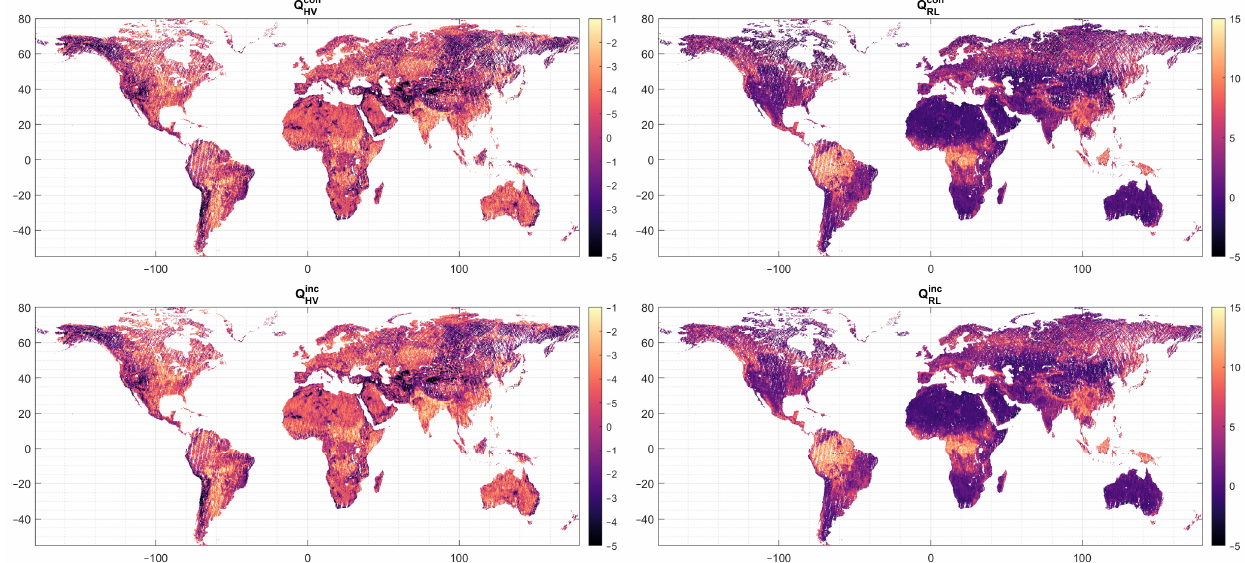
Figure 6. Polarization decoupling factor (Q) in dB units, for coherent and incoherent HV and RL ratios.